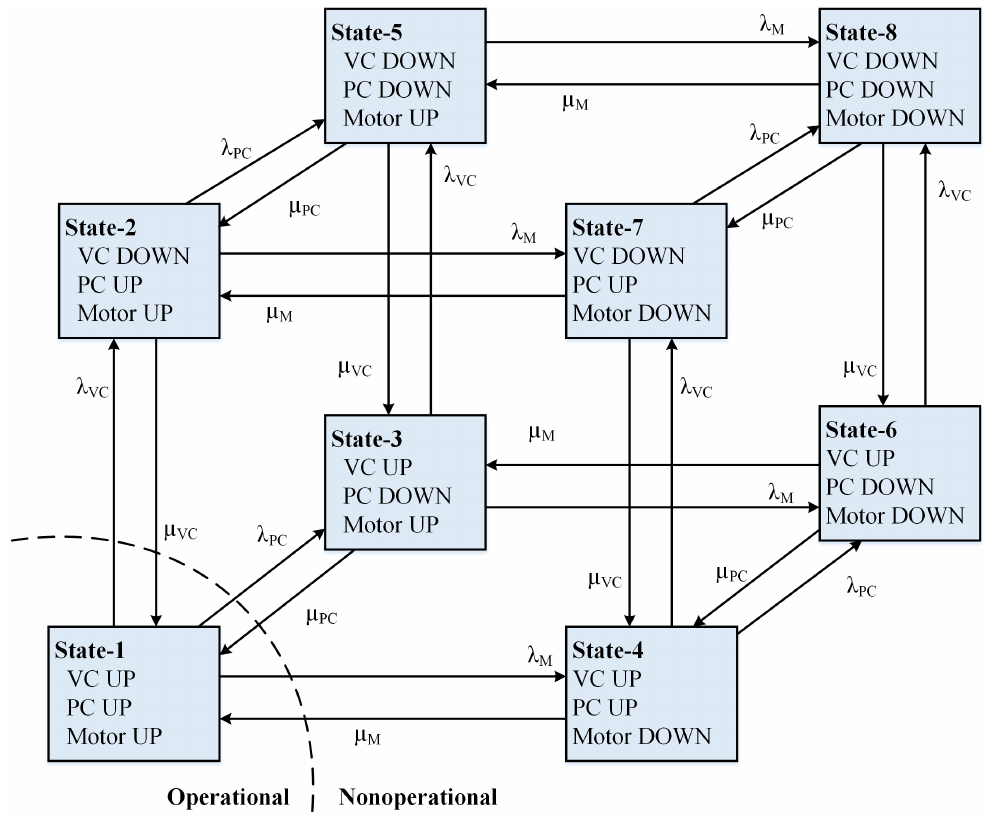
Figure 5. State-space diagram of the Electric Propulsion